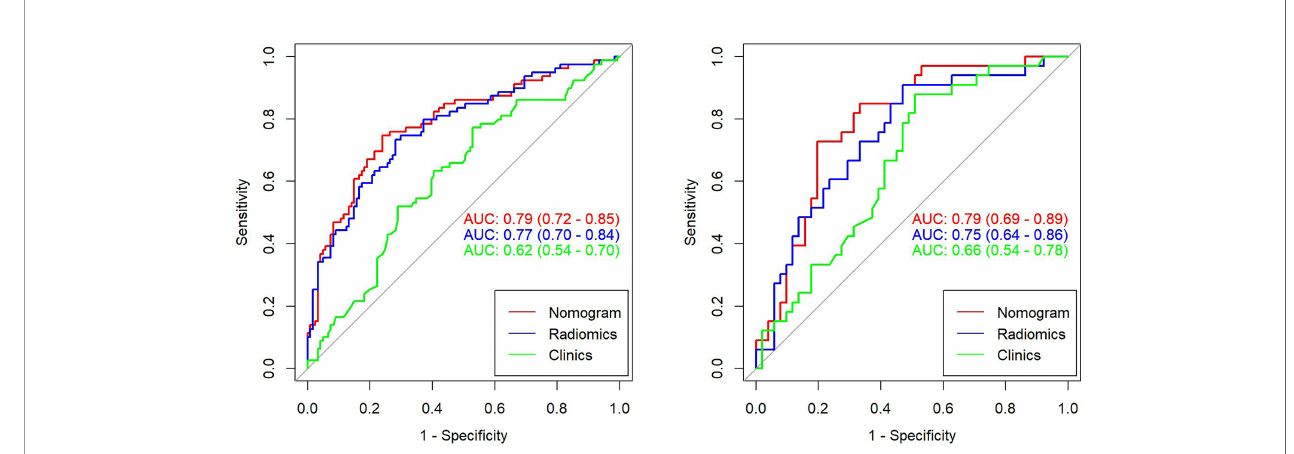
FIGURE 10 | Receiver operating characteristic (ROC) curves for the clinical model, radiomics model, and clinical radiomics nomogram based on the T1-weighted imaging (T1WI) sequence for the training set (left) and test